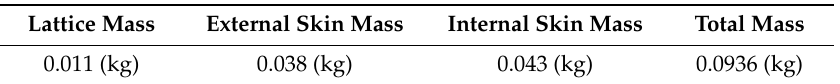
Table 5. Test case 3—Mass budget.